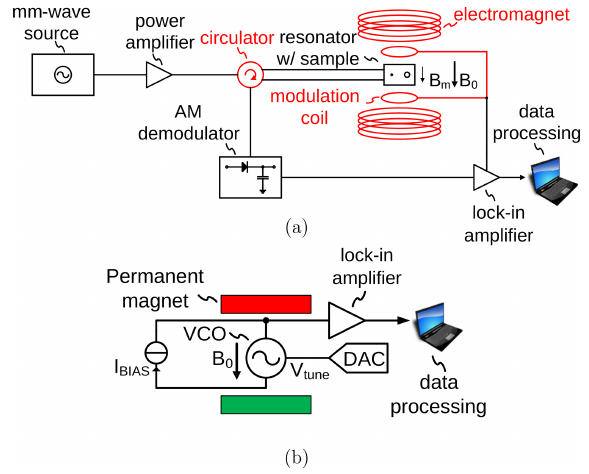
Figure 1. (a) Conventional ESR detection setup and (b) proposed ESR detection scheme, which measures the ESR effect as a change in the oscillation amplitude of an integrated LC tank VCO.